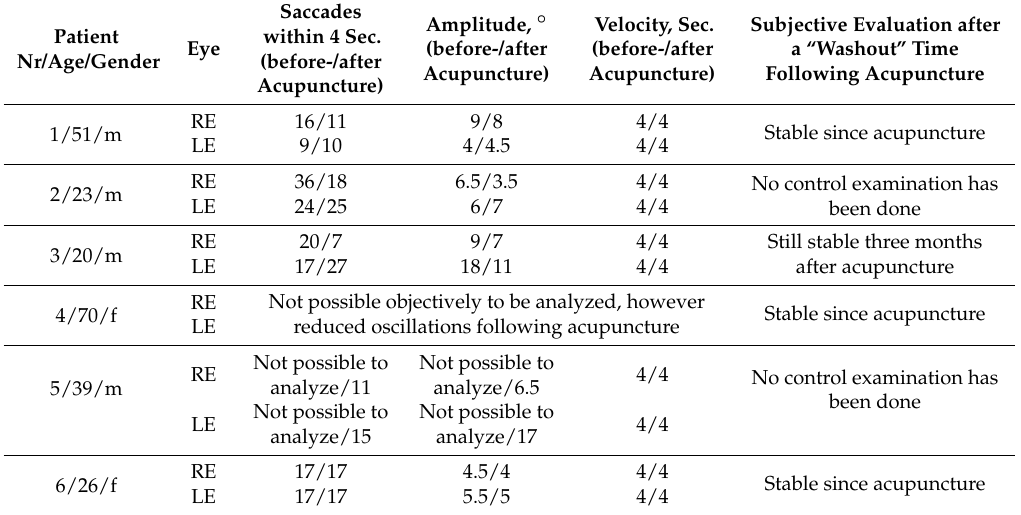
Table 3. Summarized nystagmography results of all patients before ‐ and after acupuncture treatment. In order to reduce the influence of the head position and the effect of convergence, each patient was asked to keep both eyes during the examination open while the measurement was performed monocularly, in primary gaze, keeping fixation for distance.